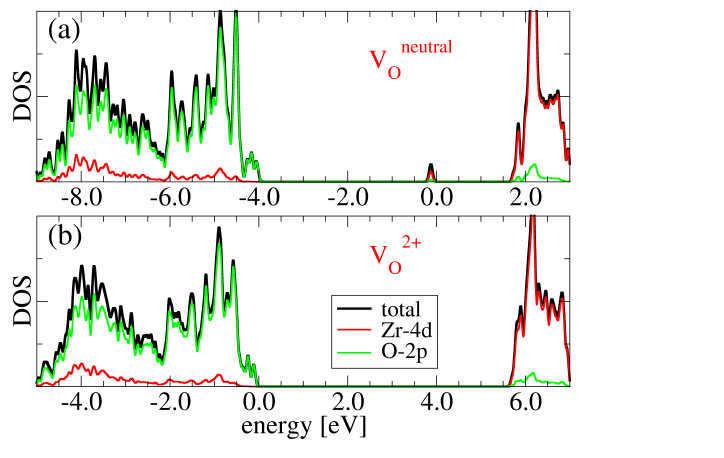
Figure 4. DOS for c-ZrO 2 with an oxygen vacancy: ( a ) for the case of V O ; ( b ) for the case of V O 2+ . The Fermi level has been set to 0